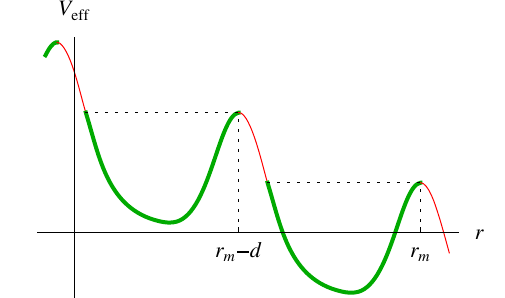
r Þ of a bent crystal. eff ð V r 0 Þ . Thick green curve r 0 ≥ r eff ð